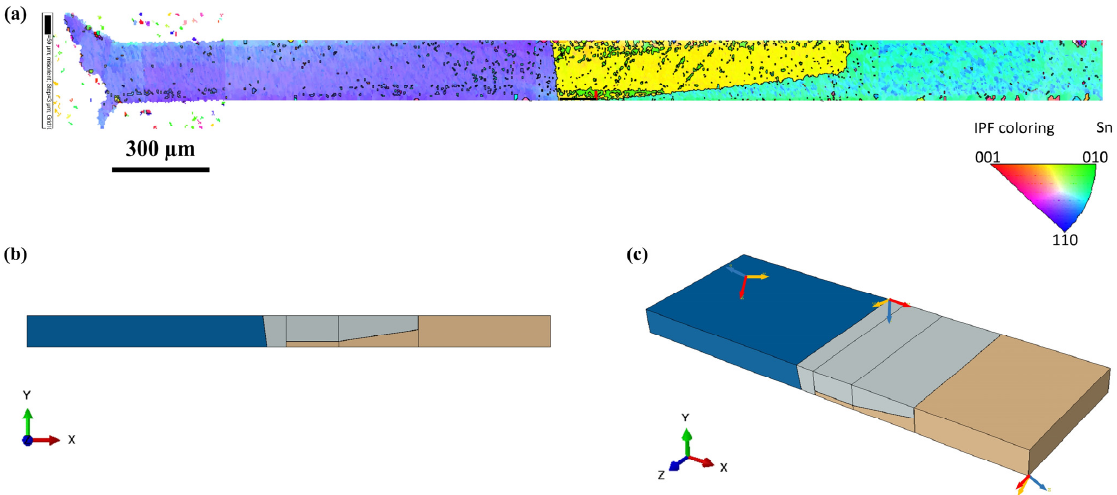
Figure 6. Grain structure of Sample 2 [21,22]: ( a ) EBSD image, ( b ) grain structure in FEA, ( c ) local coordinates indicating the direction of each grain of Sample 2.